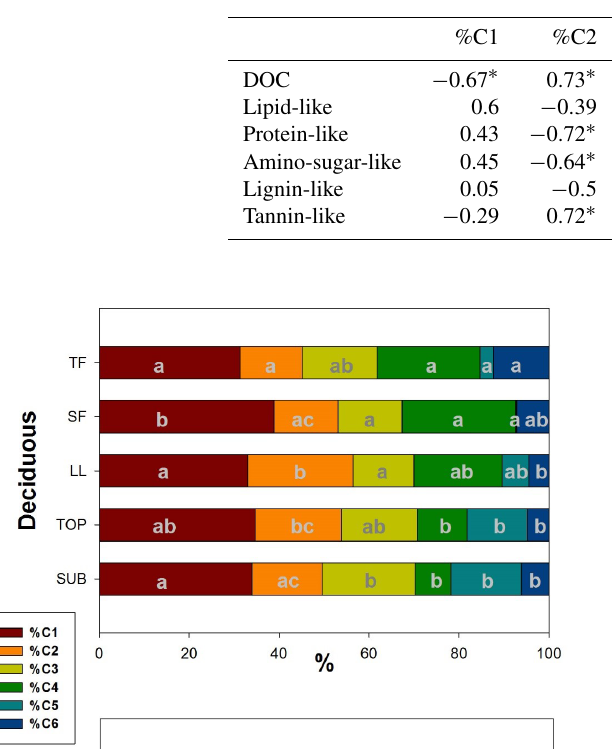
Table 4. Spearman’s rho for the correlation between the percentage relative abundances of PARAFAC components (%C1–%C6) and the relative abundances of biopolymers extracted from FT-ICR-MS van Krevelen plots. Significance level: ∗ p < 0 . 05; ∗∗ p < 0 . 01.